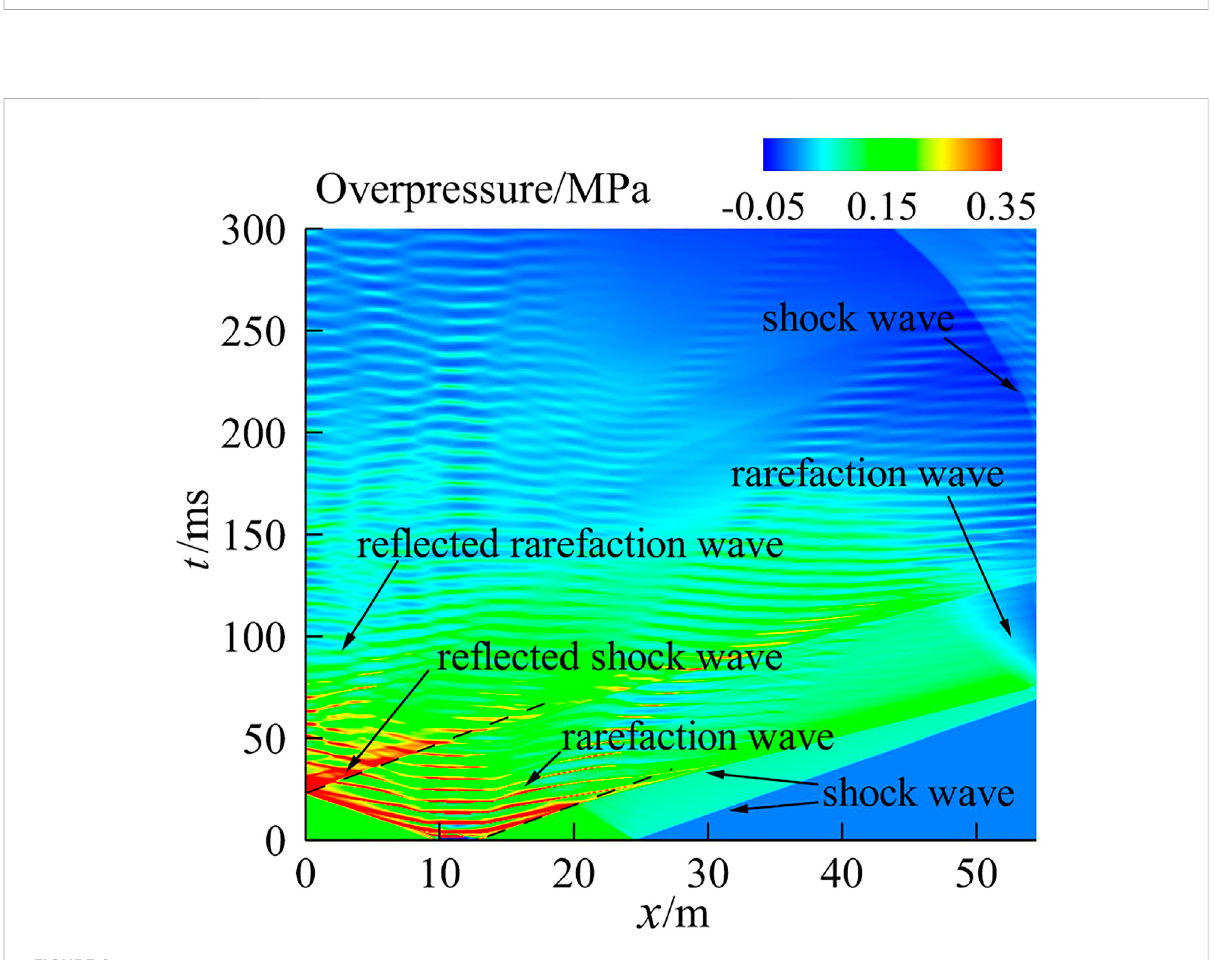
probe 1 and probe 2 has little change. Hence, it should control the suitable time of the platform segment and positive pressure duration by adjusting the location of the target in the experiment section to simulate the triangle waveform generated by explosion.